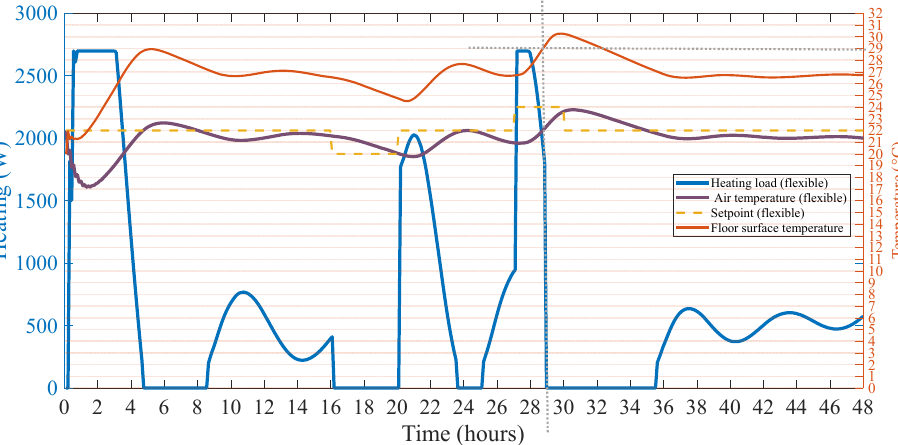
Figure 14. Stoppage of heating when floor surface reaches 29 °C.